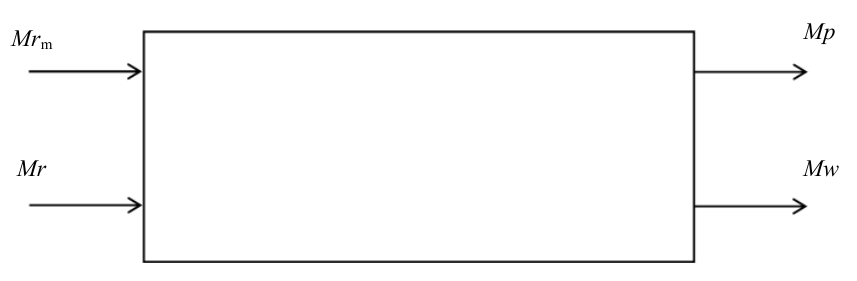
Fig. 1. ‘Black box’ of the ChE-E system